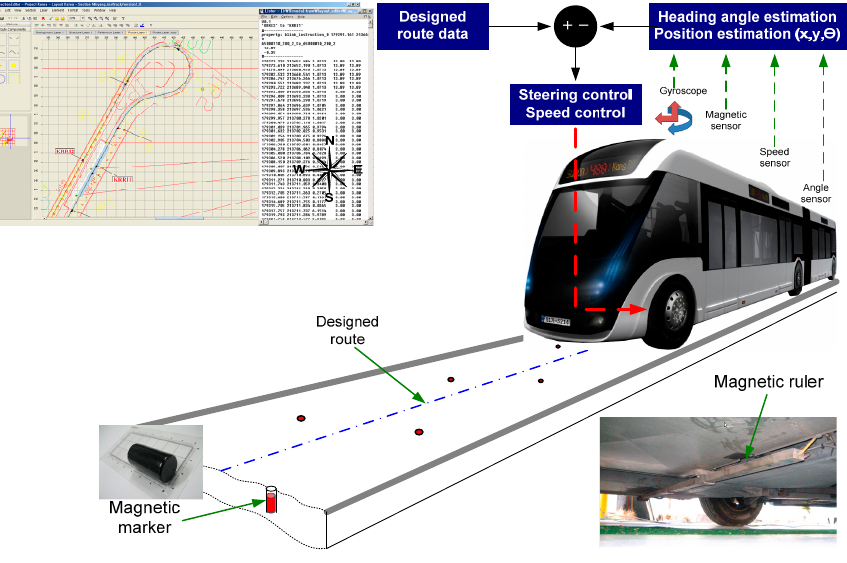
Figure 1. Schematic of automatic guidance system.